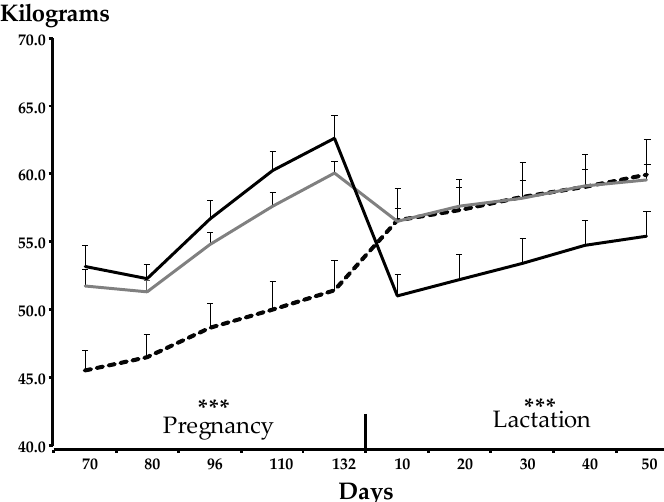
Figure 2. Trajectory of mean (± SEM) live weight, illustrating significant effects of pregnancy ( p < 0.001) and lactation ( p < 0.001), in Merino ewes bearing zero (black dotted line), one (grey solid line), or three (black solid line) fetuses, or supporting zero, one, or three lambs during lactation, in Experiment 1. Non-pregnant ewes were not lactating. p -values: *** p < 0.001.